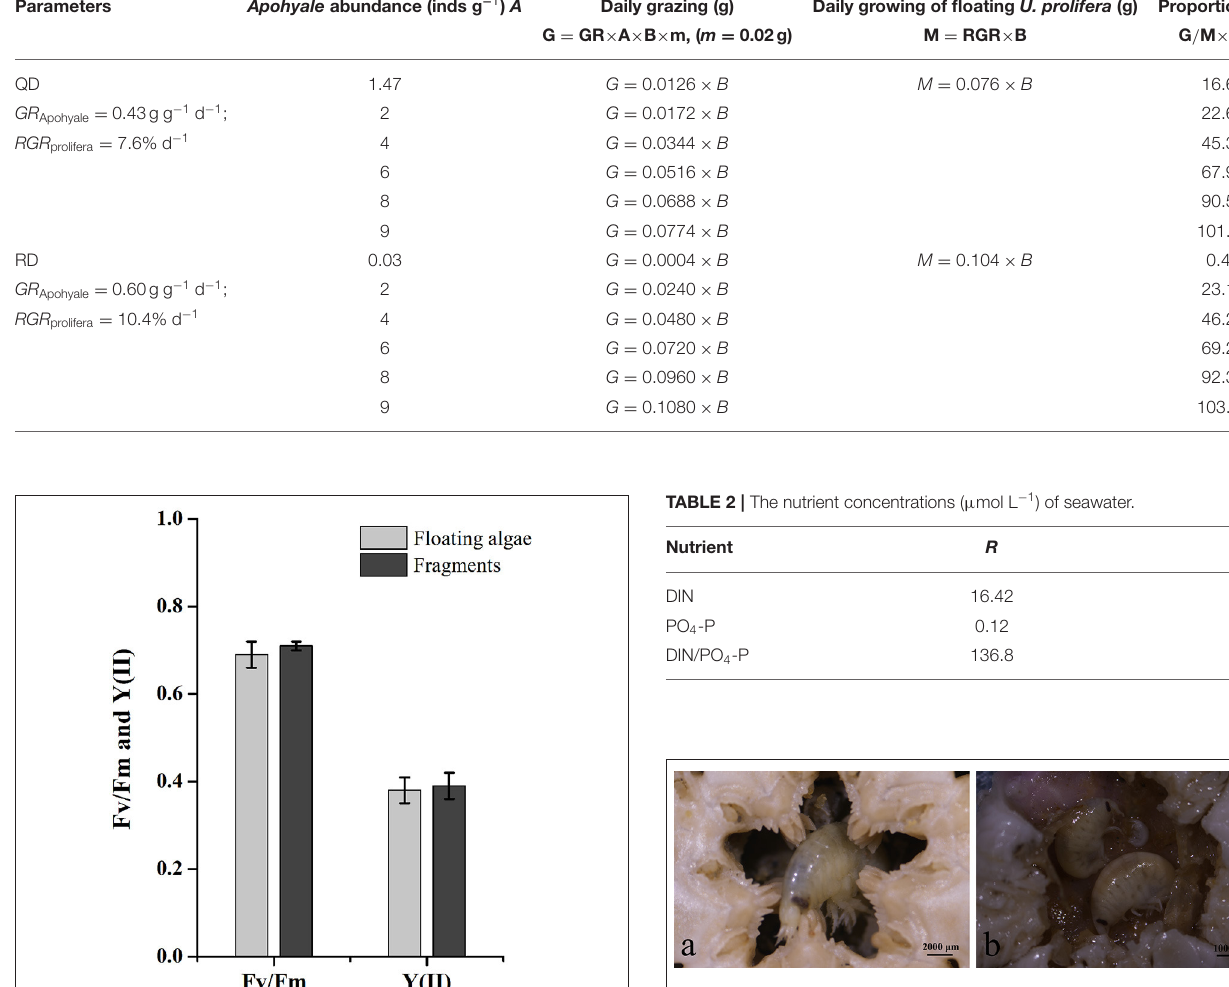
TABLE 1 | Simulating grazing effects of Apohyale sp. on the floating biomass of U. prolifera . Parameters